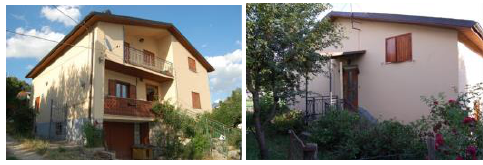
Figure 1. Photographs of the exterior of the building.